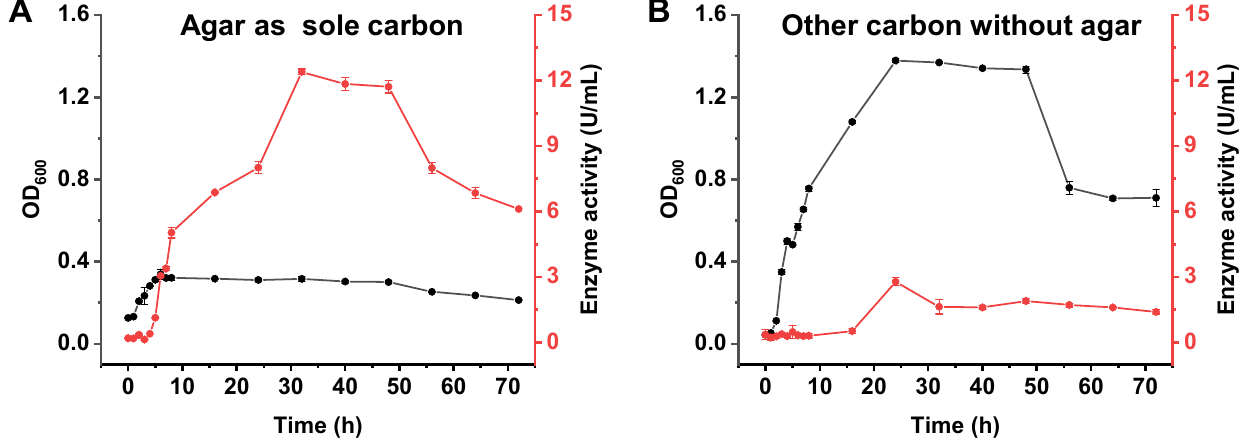
Figure 2. The curves of growth and agarase production of A. macleodii QZ9-9 in agar-enriched medium ( w / v : containing 0.2% agar, 3% NaCl, 0.5% (NH 4 ) 2 SO 4 , 0.2% K 2 HPO 4 , 0.1% MgSO 4 · 7H 2 O and 0.01% FeSO 4 · 7H 2 O, pH 7.5) with agar as the sole carbon source ( A ) and agar-deficient medium ( w / v : containing 0.5% tryptone, 0.1% yeast extract, 100 mL seawater, pH 7.5) that other carbon instead of agar as the carbon source ( B ).